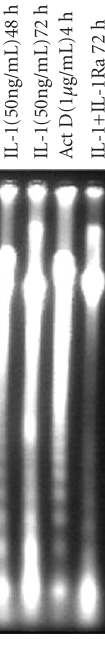
Figure 2: IL-1 induction of DNA fragmentation. JAR cells were cul- tured in serum-free RPMI 1640 with or without IL-1 (50ng/mL) for 24, 48, and 72 hours. Inhibition of DNA fragmentation was also per- formed using IL-1Ra. DNA samples were extracted and fractionated by agarose gel (1.5%) electrophoresis and DNA ladders were visual- ized after gel